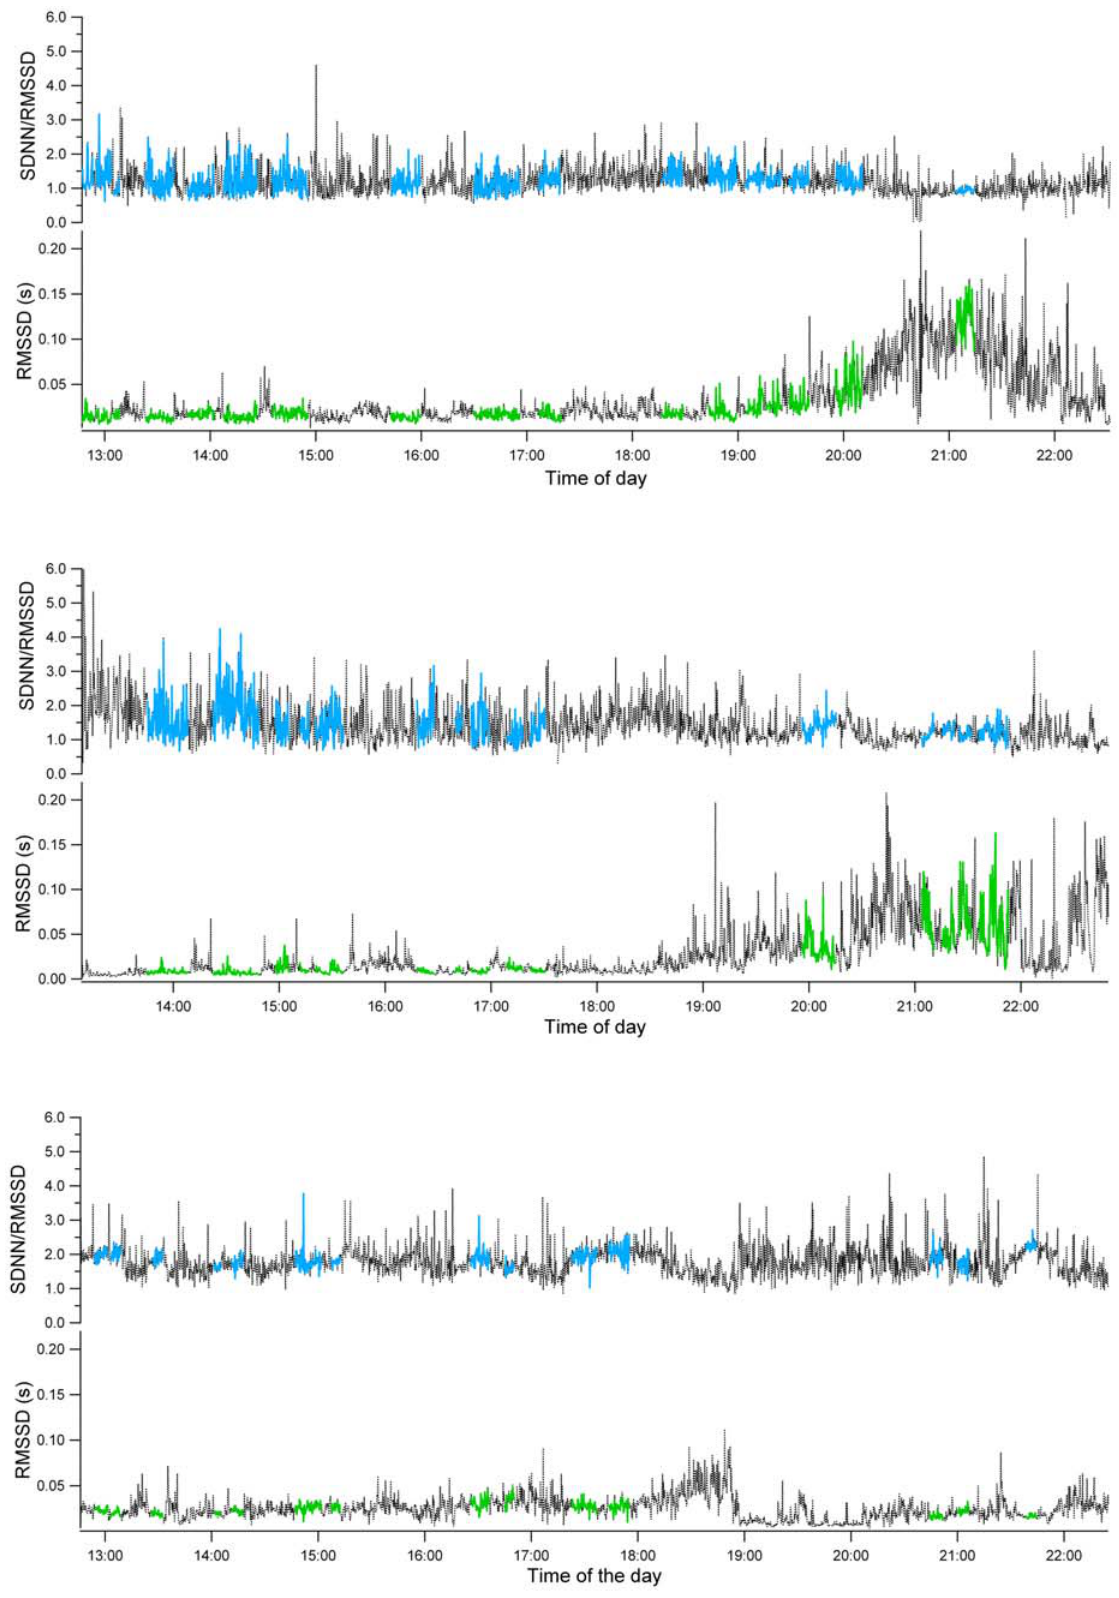
Figure 6. RMSSD and SDNN/RMSSD ratio (see Methods) for a) Nemo, b) Nugget and c) Crimson. In each figure, the lower and upper curves depict the evolution of the RMSSD and the SDNN/RMSSD, respectively, over the complete (dotted black) recording period. Each period of inactivity (green for RMSSD and blue for the ratio) used to calculate the power spectrum of Fig. 4 and 5, are also indicated for information.